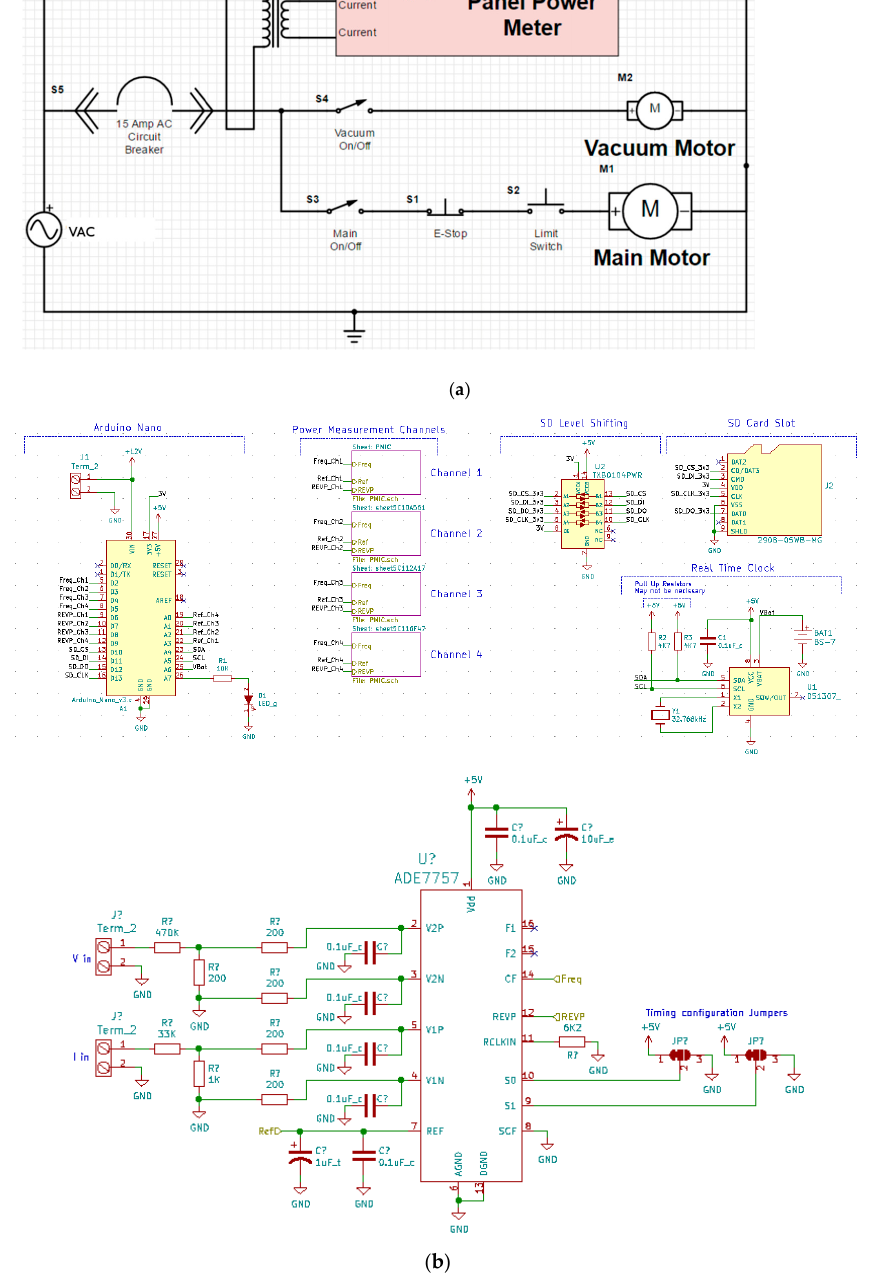
Figure 4. ( a ) Circuit diagram for electrical control system of the open source waste plastic granulator and ( b ) circuit